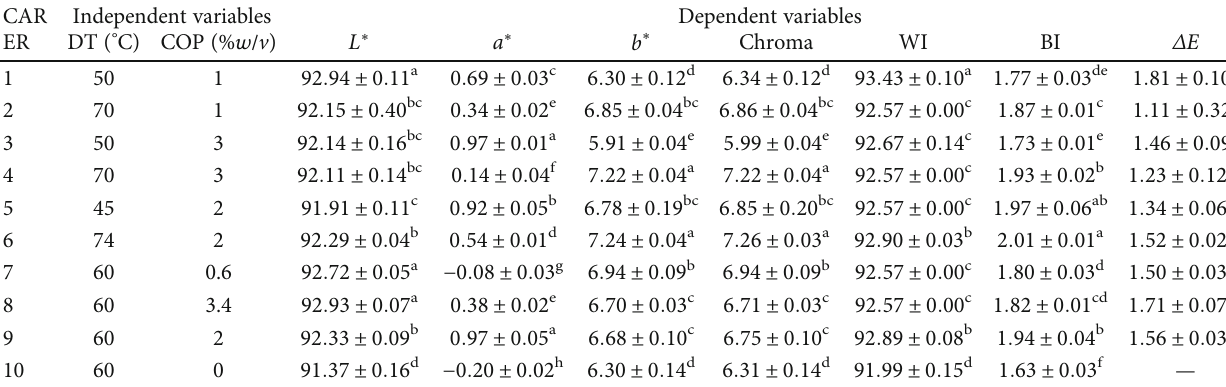
ER — experimental run; DT — drying temperature; COP — concentration of pretreatment; CAR — cassava from red landrace pretreated with citric acid; L ∗ — lightness/darkness; a ∗ — redness/greenness; b ∗ — yellowness/blueness; WI — whiteness index; BI — brownness index; Δ E — total colour change. Values are mean ± standarddeviation ( n = 3 ). Means in the same column with di ff erent superscripts are signi fi cantly di ff erent at 95% con fi dence level.